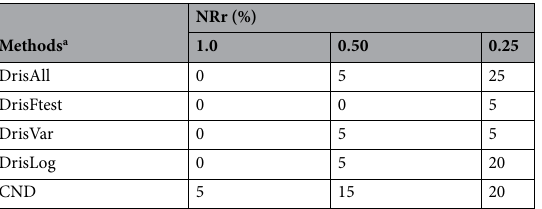
Table 1. Percentage of deficiency diagnosis interpreted by the DRIS and CND methods, as a function of the nutrient responsiveness range (NRr) for B diagnosis in soybean, cultivated in Chapadão do Sul, Mato Grosso do Sul, Brazil. a Methods DRIS adopting the criteria of selecting all bivariate relations—DrisAll, using the criterion Ratio of Variances—DrisVar, using the F test—DrisFtest and using the logarithmic transformation— DrisLog and compositional nutrient